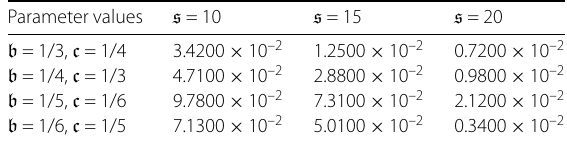
Table 4 Absolute error in boundary conditions of y ( t ) of Example 6.3 for different values of parameters b and